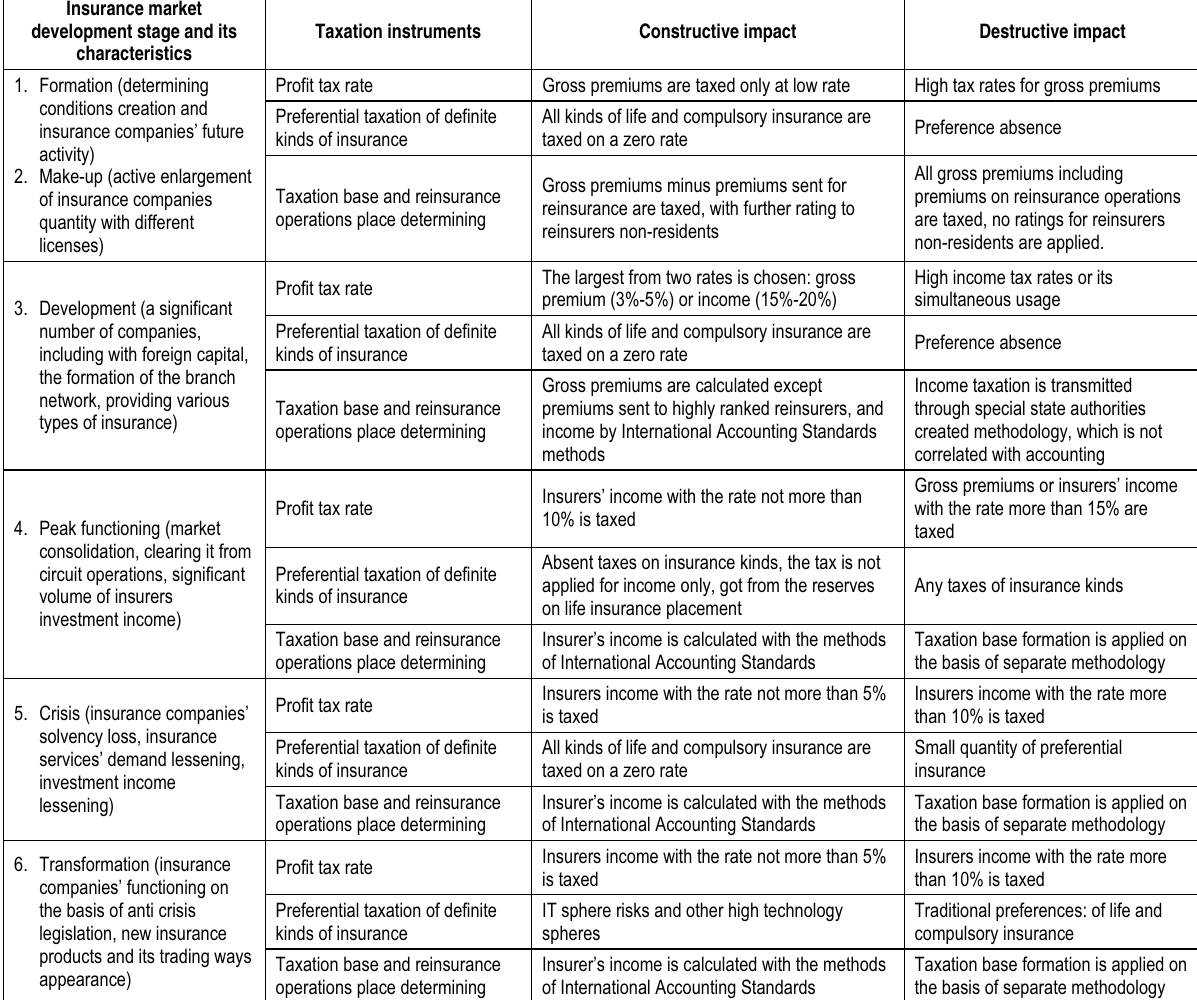
Table 1. Taxation instruments impact on insurance